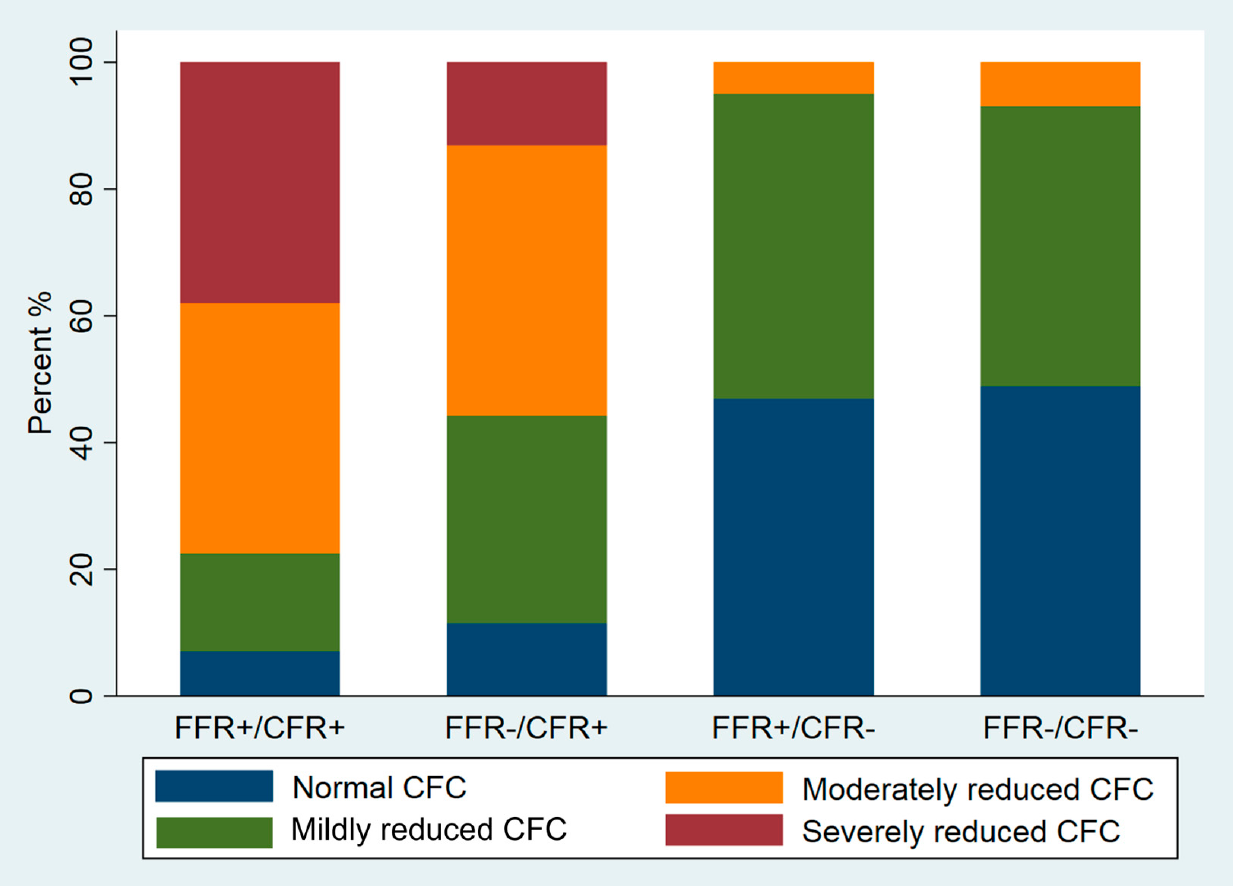
Figure 2. Stack bar graph of CFC frequency in all four FFR/CFR groups.